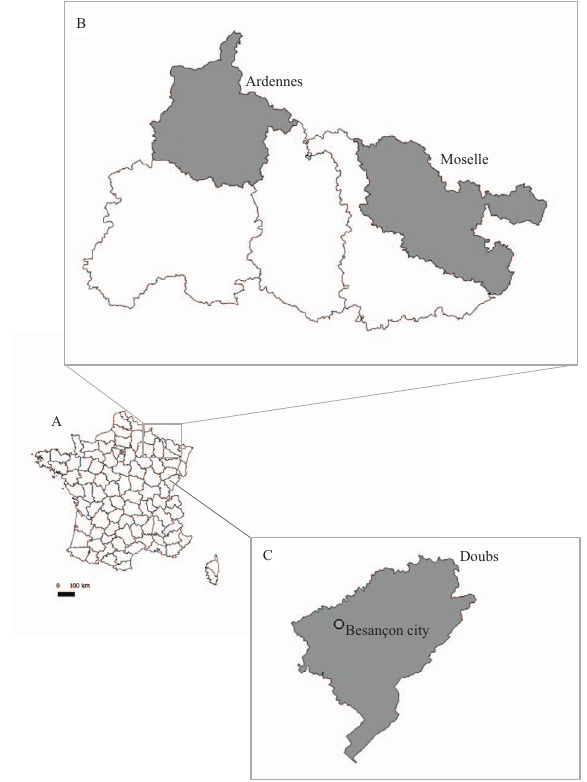
Figure 1. Localisation of the three study areas in France (A), highlighting the rural (B) and urban (C)